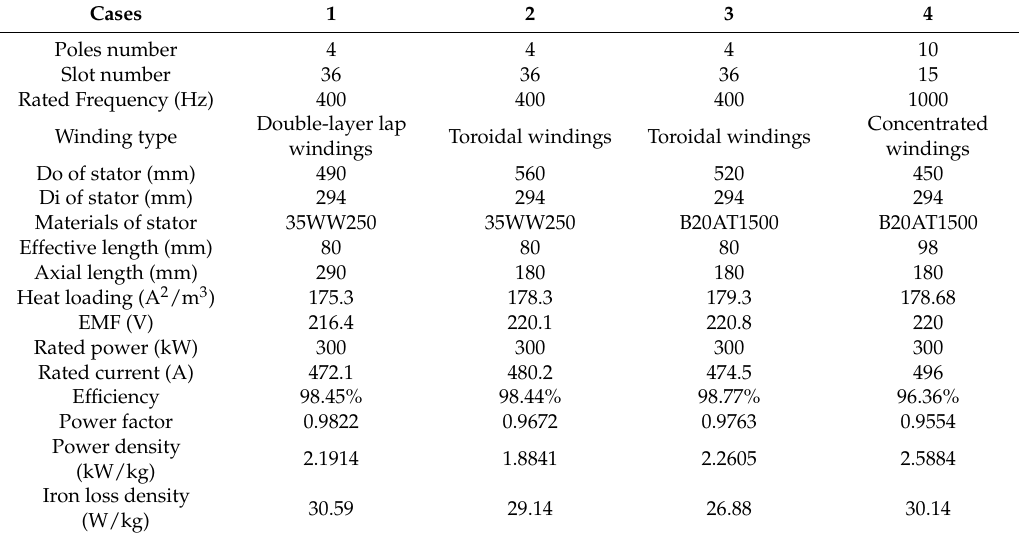
Table 1. Specifications of the four designs of the